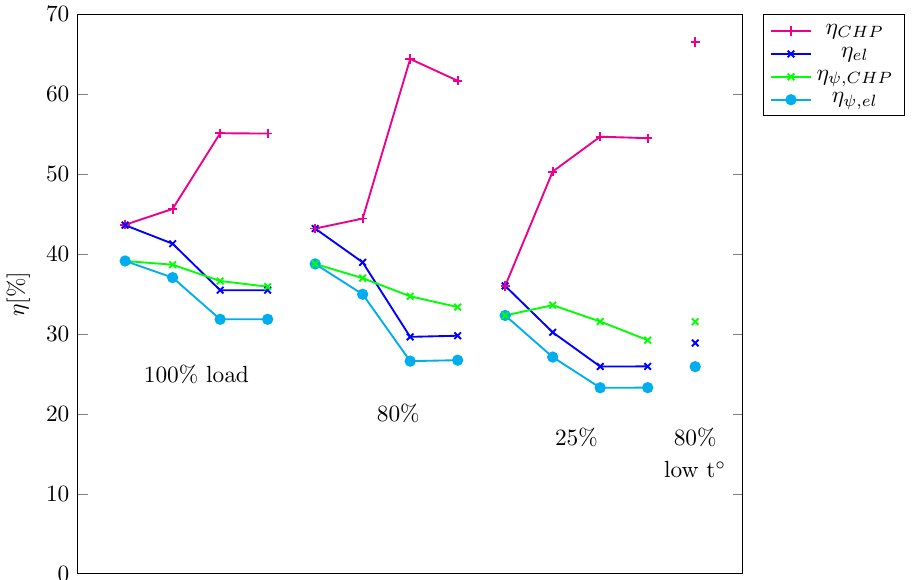
Figure 4. Energy and exergy efficiencies for the 13 scenarios defined Table 5. Figure 4: Energy and exergy efficiencies for the 13 scenarios defined Table ?? . As expected, η CHP is equal to η el and η ψ , CHP is equal to η ψ , el for the cases without steam extraction (Base Cases for 100%, 80% and 25% loads). These efficiencies do not significantly As expected, η CHP is equal to η el and η ψ,CHP is equal to η ψ,el for the decrease between full load and 80% load (around 43%), but they are approximately 7% lower at minimum load. From an operational point of view, this shows that a limited load cases without steam extraction (Base Cases for 100%, 80% and 25% loads). decrease ( 20%) does not significantly affect the electrical performances of the plant, which − is of course beneficial in terms of